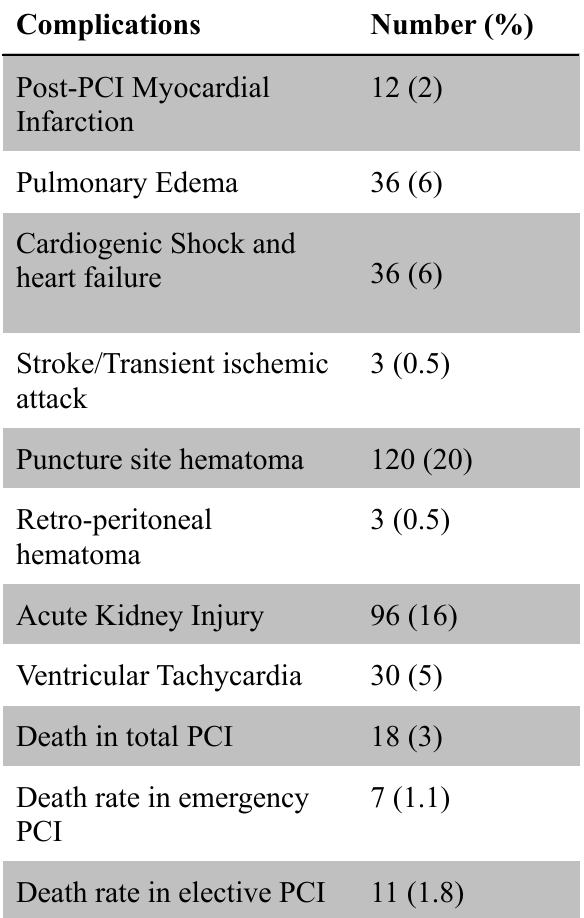
Table3. Post PCI Complications during hospital stay (N =